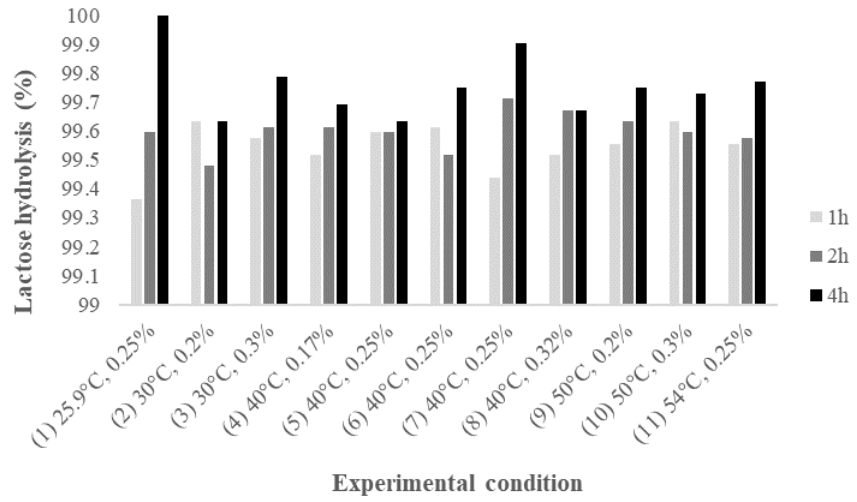
Figure 1. Effects of temperature and amount of enzyme on lactose hydrolysis (%) (1, 2, and 4 h) for each experimental condition evaluated as determined by HPAEC-PAD.